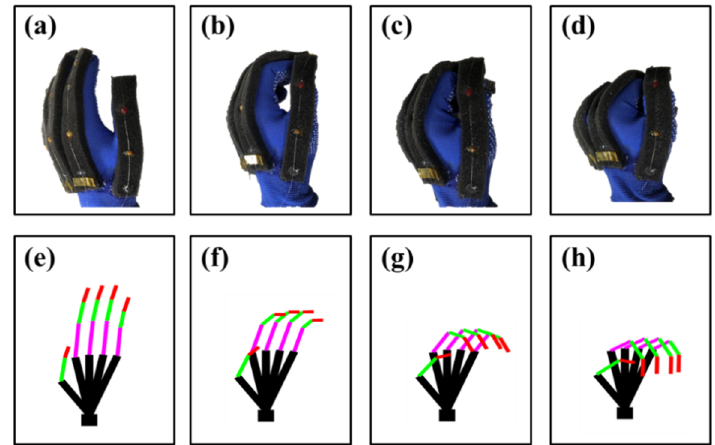
Figure 7. Calibration of finger posture. ( a ) Extension of the palm. ( b ) Slightly extension of the palm. ( c ) Slightly fist of the palm. ( d ) Fist of the palm. ( e ) Model of extension. ( f ) Model of slightly extension. ( g ) Model of slightly fist. ( h ) Model of fist.